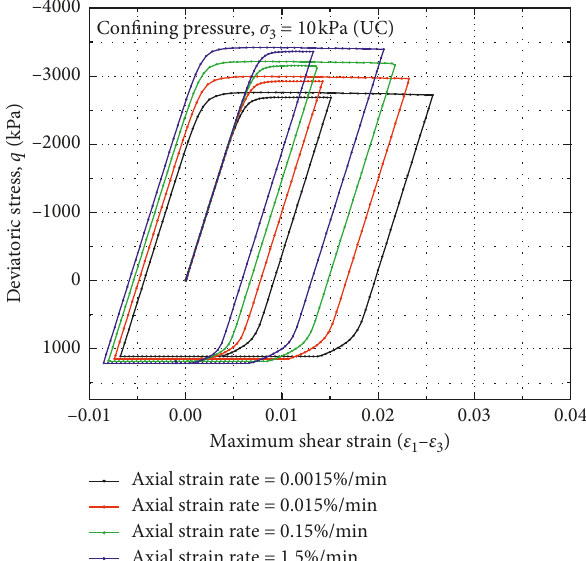
Figure 9: Deviatoric stress versus maximum shear strain for various strain rates under a single confining stress of 10kPa. Displacement control cyclic analysis is done in both compression and extension directions.